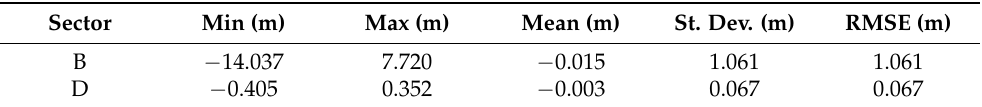
Table 6. Statistical terms of the residuals between the Universal Kriging model with 2400 total points and initial dataset values for B and D sectors.